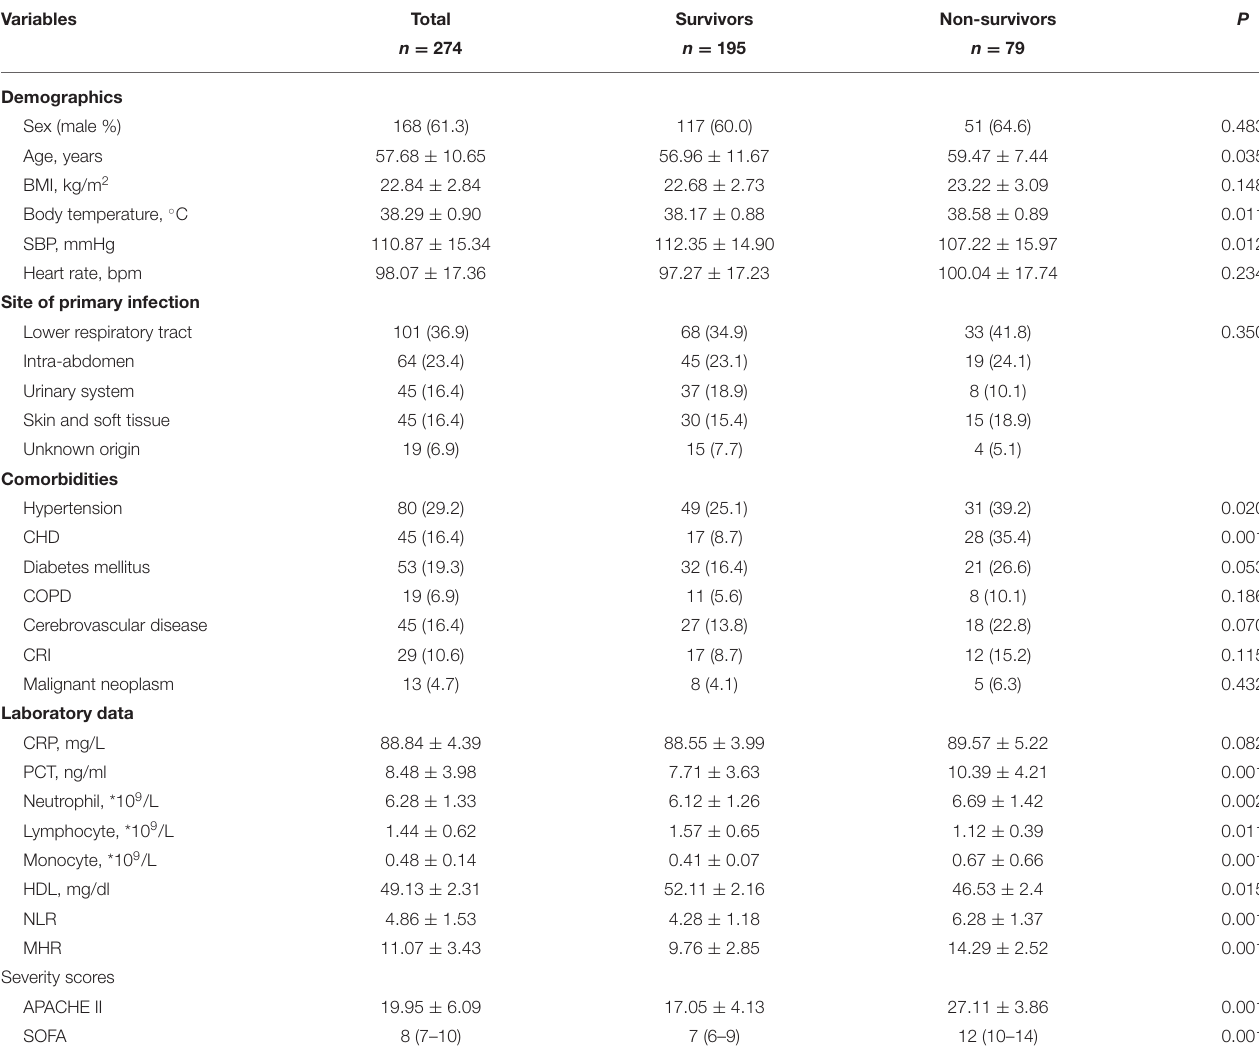
TABLE 1 | Baseline characteristics of studied